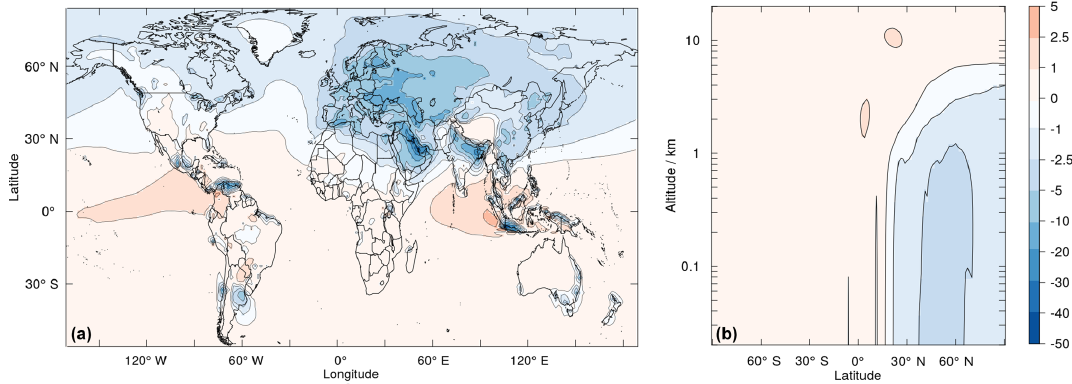
Figure 9. Annual mean percentage change in O 3 concentration at the surface (a) and as a zonal mean (b) .